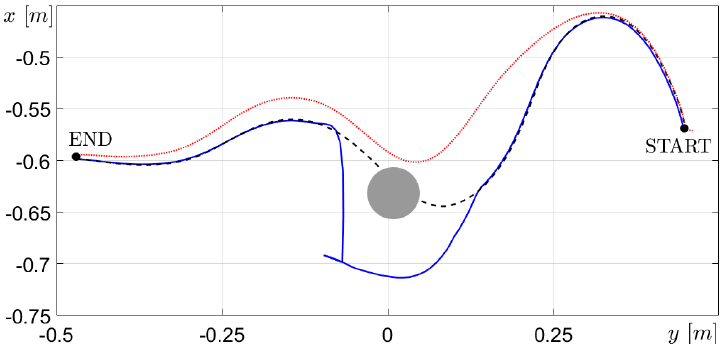
Figure 5. Comparison between the trajectory generated with the proposed algorithm (solid blue line) and the one generated with the repulsive potentials method (dotted red line). The nominal trajectory is depicted with a dashed black line and the obstacle with a ray